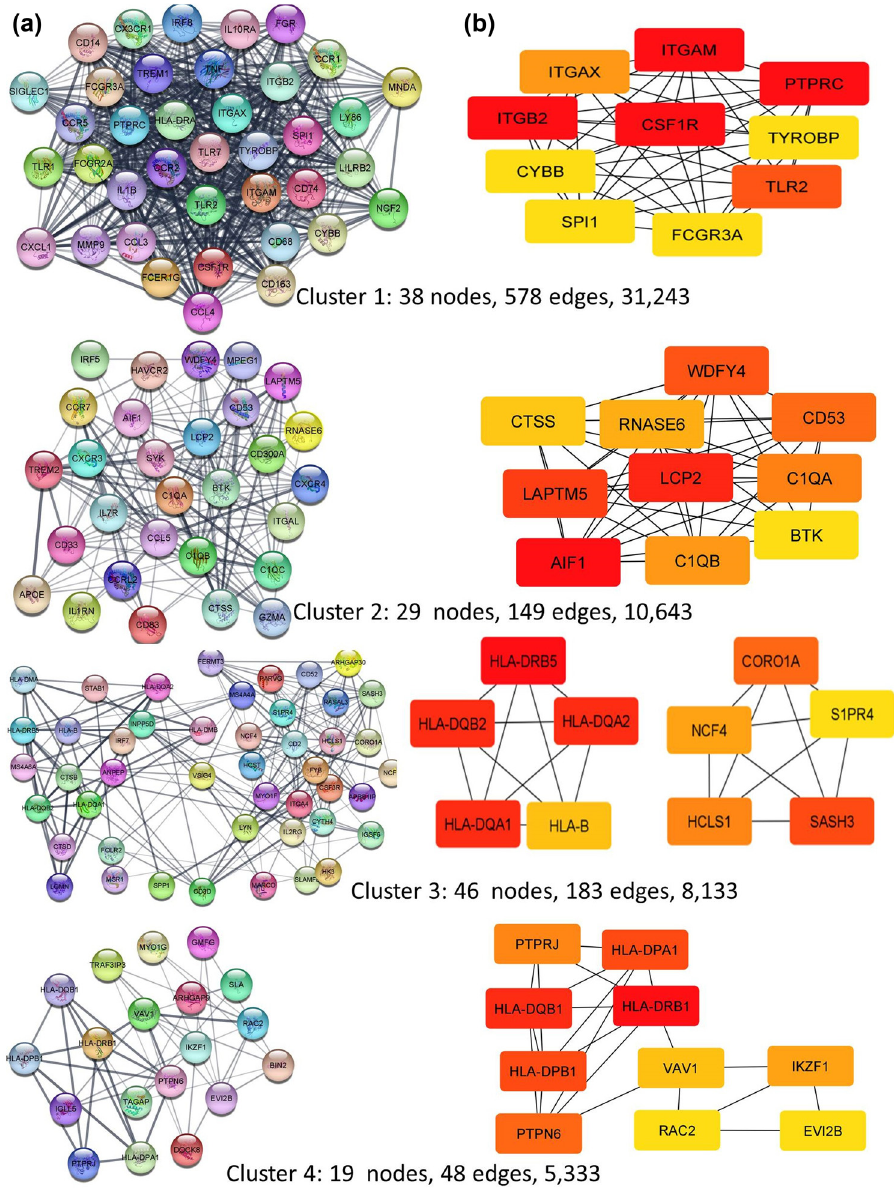
Figure 9: The most important clusters selected from the PPI network ( a ) . A node in the PPI network denotes a protein and an edge denotes an interaction. The most important genes evaluated in the PPI network using the MCC algorithm in CytoHubba, Cytoscape ( b ) . The most important genes are ranked as follows: the most important genes are highlighted in red, the less important in orange, and even less important in